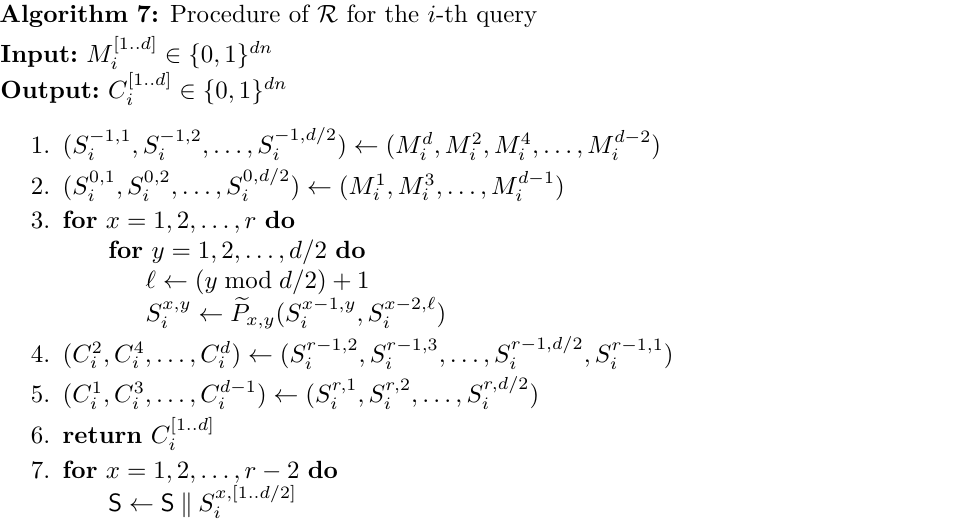
Algorithm 8: Procedure of R − 1 for the i -th query